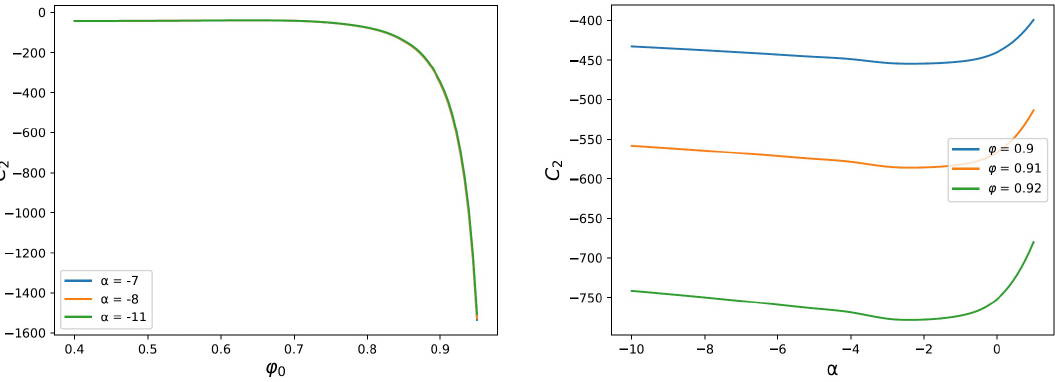
as a function of α for fixed values of ϕ 2